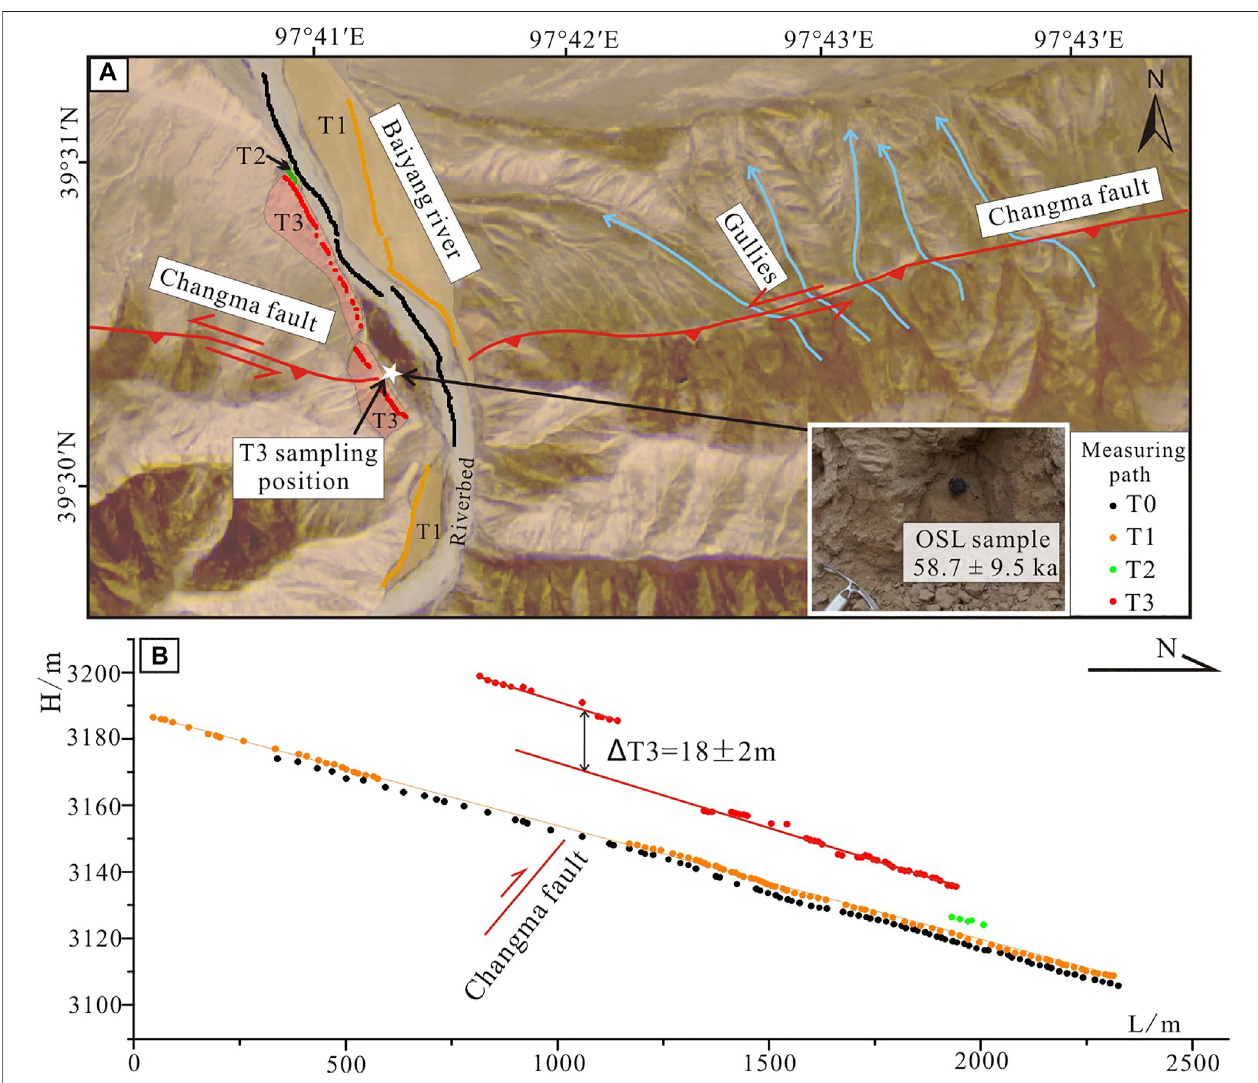
FIGURE5|(A) SatelliteimageoftheBaiyangriverneartheChangmafaultshowingtheterracedistribution.Theredlinesrepresentthefaulttraces.Thecoloreddots denote the measuring paths of terraces. The blue lines show the faulted gullies in this region. The white fi ve-pointed star shows the location of the optically stimulated luminescence(OSL)sample.Theimagerangeisshownintheblackrectangleof Figure8A . (B) Thelongitudinalpro fi lesofterraces(T1 – T3)andthemodernriverbed(T0) of the Baiyang river showing the offset of the terrace T3 (modi fi ed from Liu R. et al., 2017).